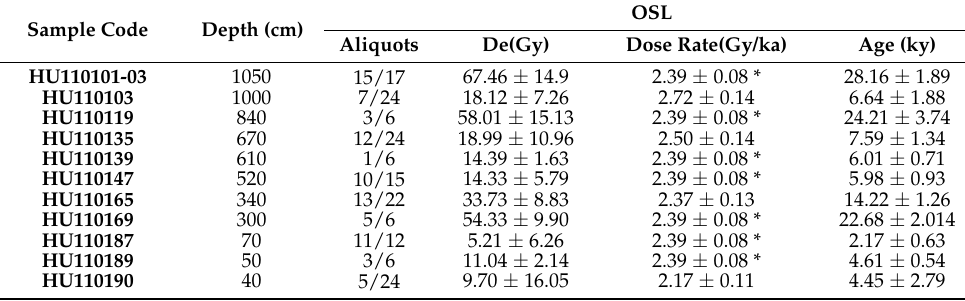
Table 2. Equivalent doses, dose rates and quartz luminescence ages.